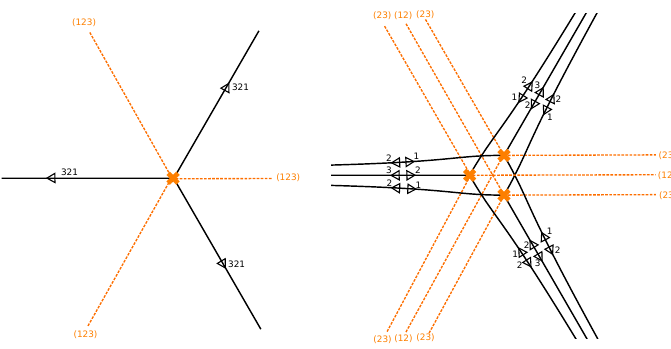
Figure 30 . The covering Σ → C and the critical leaves around a simple zero of φ 2 . Left: the picture when φ = z d z 2 and φ = 0 . Right: the picture with a small nonzero φ 2 3